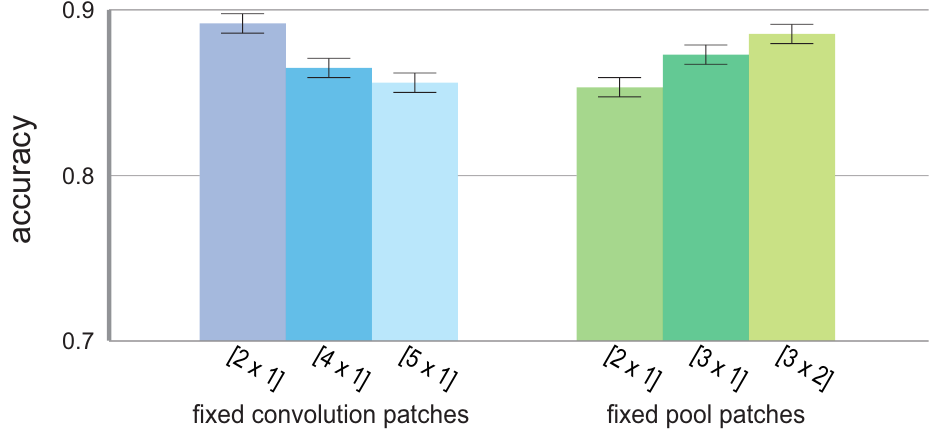
Figure 4. Mean accuracy, along with the accuracy’s standard deviation, for all models with fixed convolution patches (left) and pool patches